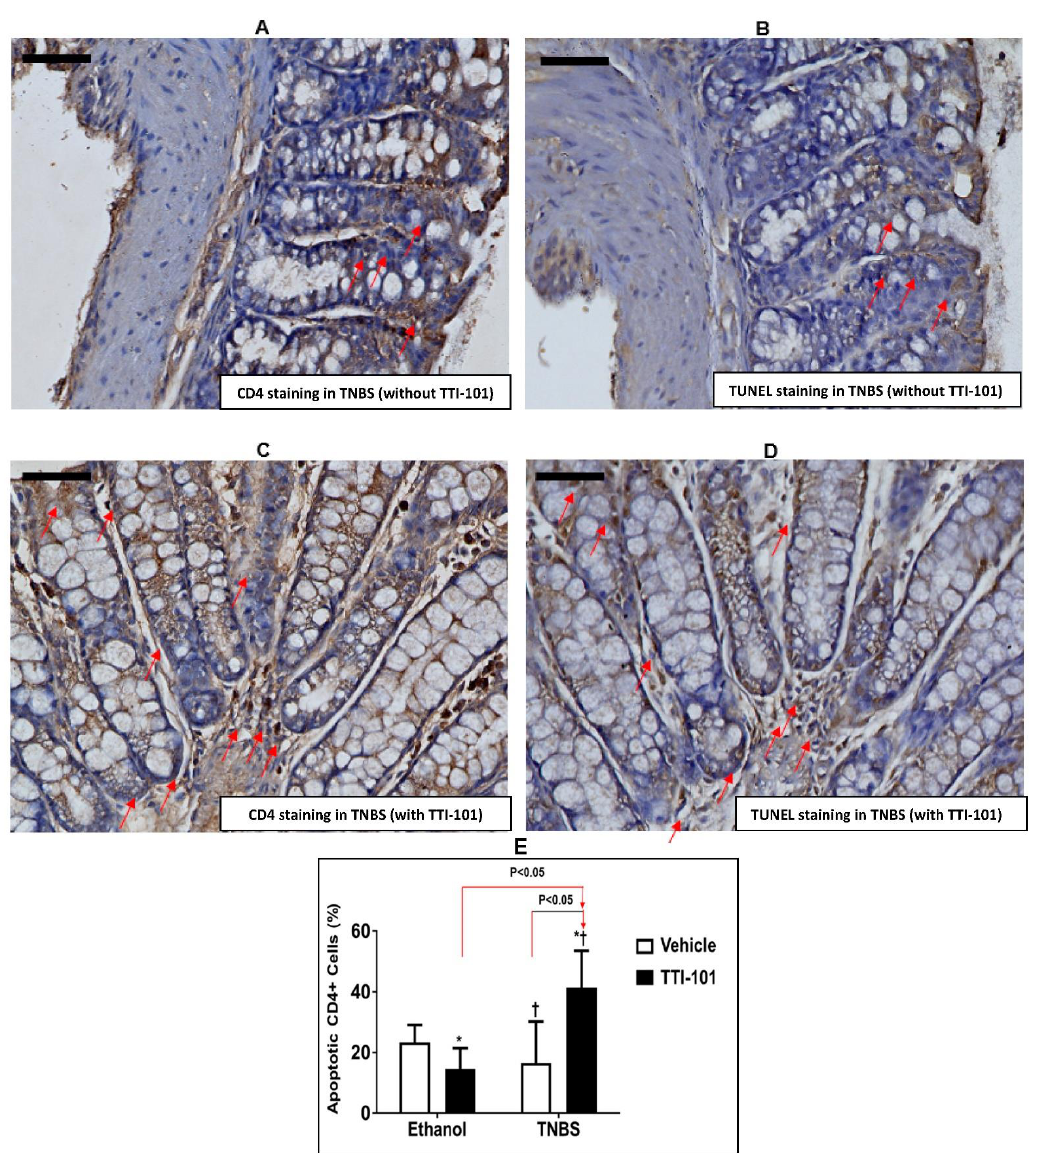
Figure 4. Effect of TTI-101 treatment on TNBS-induced apoptosis in CD4 cells. ( A , B ) Photomicro- graphs of CD4 and TUNEL stained sections of colon tissue derived from TNBS mice without TTI-101 treatment and from ( C , D ) TNBS mice with TTI-101 treatment, respectively (magnification 400×). Red arrows depict cells positively stained for CD4 or TUNEL. Scale bar on each micrograph represents 50 microns. ( E ) Percentage of apoptosis in colonic CD4+cells in response to TNBS, with and without TTI-101 treatment. Results are expressed as mean ± SD (*, Ethanol+TTI-101 vs. TNBS and † , TNBS vs. TNBS+TTI-101; all p < 0.05, ANOVA followed by Tukey’s post-test; n =